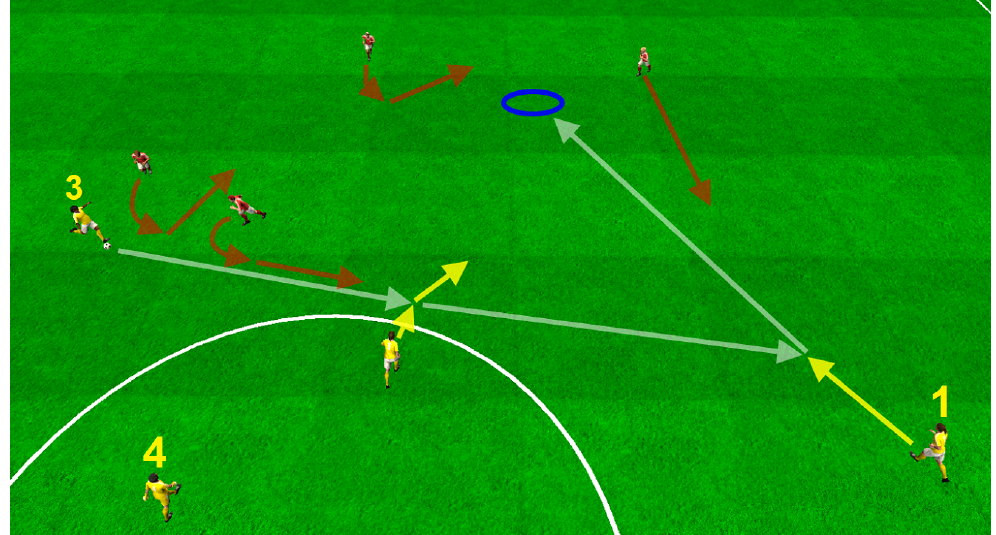
Figure 1. The illustration shows the sequence of an exemplary virtual play, including the movement paths of the individual players (yellow and red) and the ball (white). The blue circle outlines the participant’s position within the